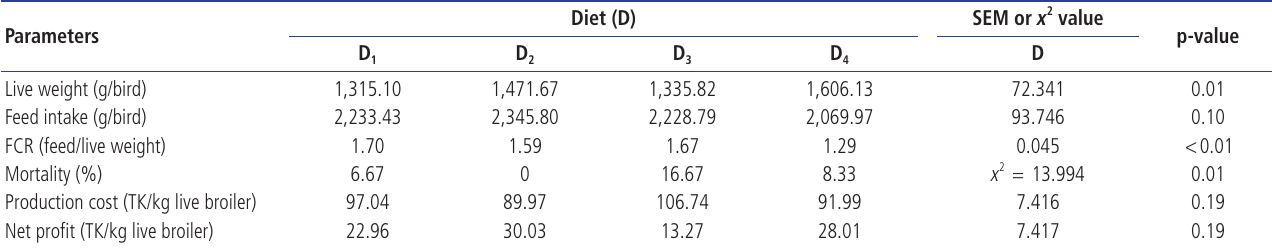
Table 2. Effect of multivitamin or acidifier on growth performance of broiler chickens at 35 days of age